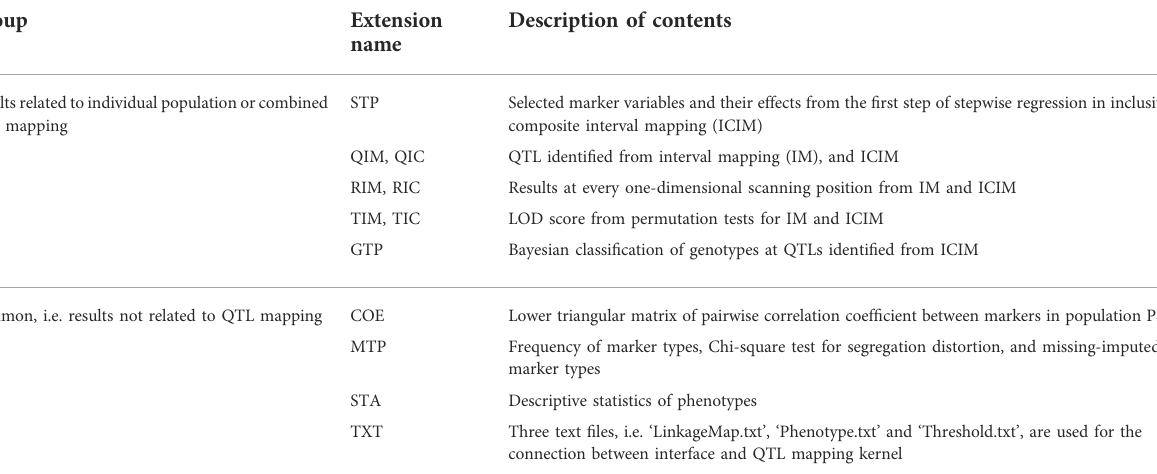
TABLE 2 Description of output fi les from the QHP functionality.